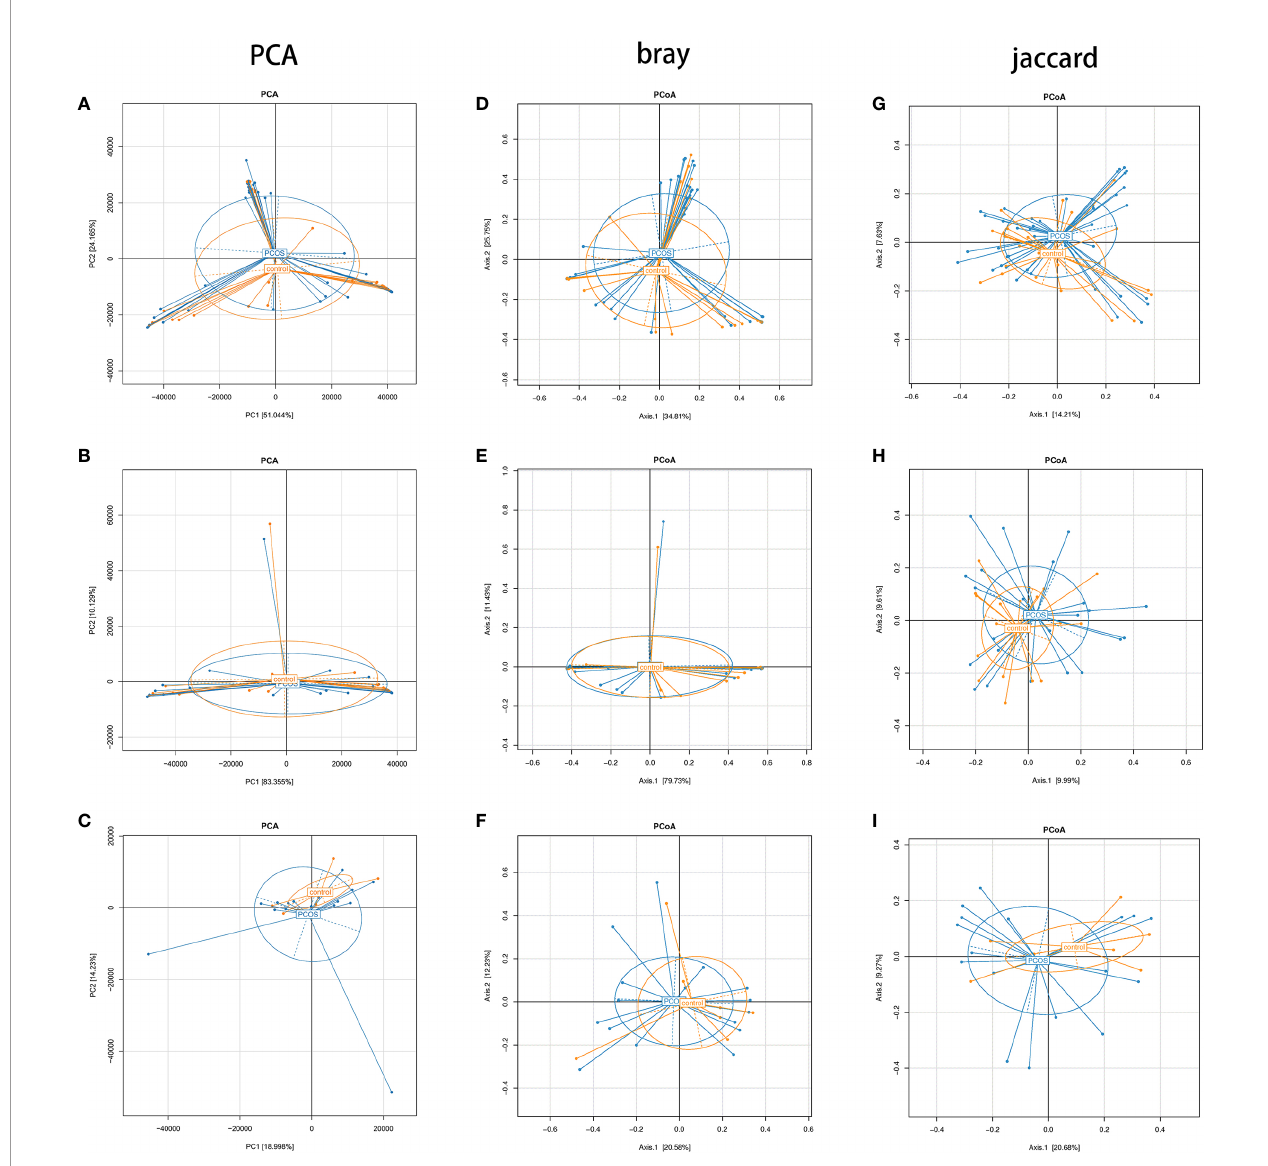
FIGURE 4 | Principal component analysis and principal coordinate analysis (PCoA) between the total polycystic ovary syndrome (PCOS) and total control groups, L-PCOS and L-control groups, and N-PCOS and N-control groups. (A – C) PCA between total PCOS group and total control group, L-PCOS group and L-control group, N-PCOS group and N-control group; (D – F) PCoA in bray distance between total PCOS group and total control group, L-PCOS group and L-control group, N-PCOS group and N-control group; (G – I) PCoA in Jaccard distance between total PCOS group and total control group, L-PCOS group and L-control group, N- PCOS group and N-control